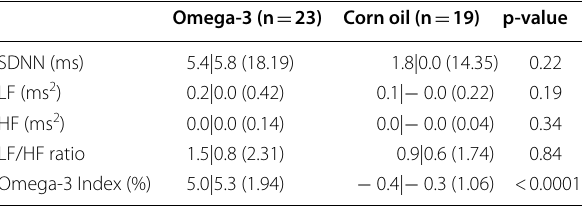
Table 6 Change endpoint vs. baseline: mean/median (SD)